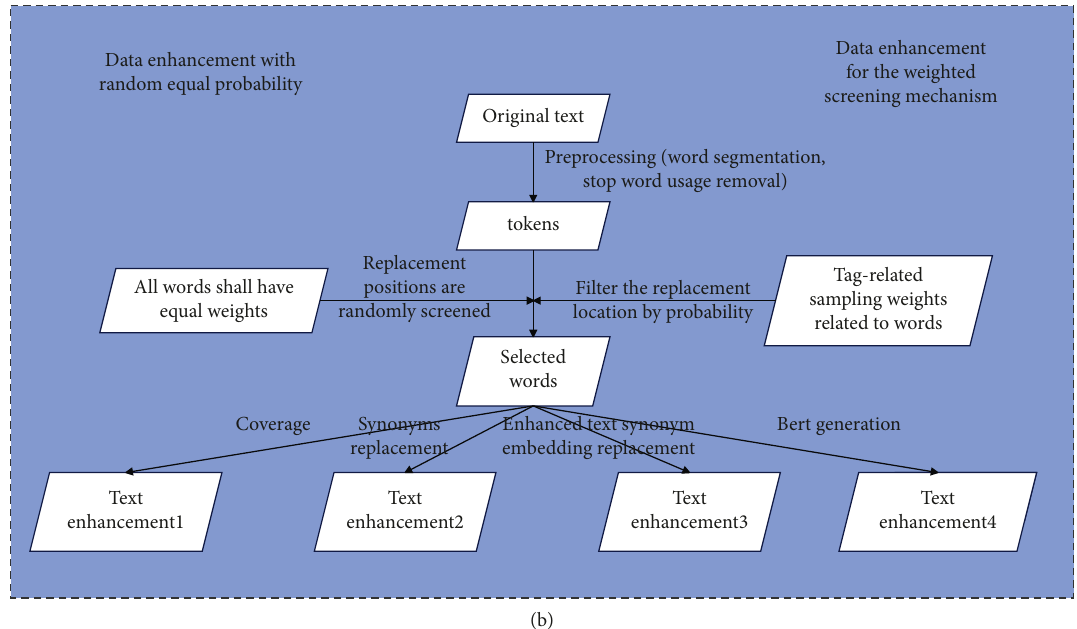
Figure 8: Text emotional data enhancement. (a) Method for calculating the relevance weight of text words and classification labels. (b) Data augmentation process.